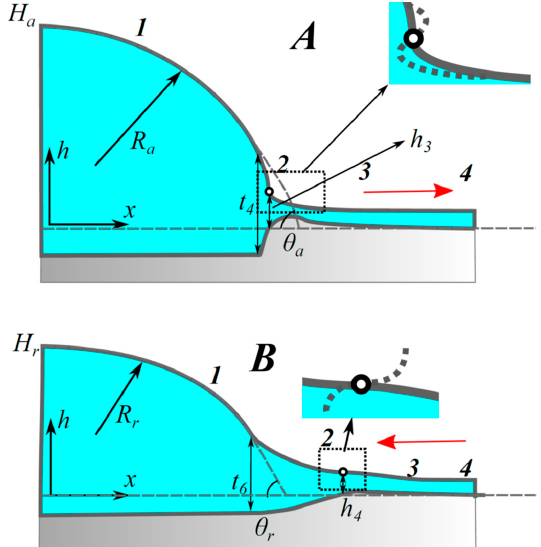
Figure 9 . Droplet on a deformable substrate: just before advancing ( A ); and just before receding ( B ) begins (1, quasi-equilibrium part of the droplet; 2, inflection points; 3, flow zone; 4, equilibrium thin liquid film in front). Reproduced with permission from [20]. Copyright © 2018 Elsevier B.V. Dangerous points (inflection points) exist in advancing and receding droplets. In advancing droplet, inflection point is present at thickness, ℎ (cid:2871) , and, in receding droplet, inflection point is present at thickness, ℎ (cid:2872) [20,40] (see Figure 9). Boundary conditions for both cases are: